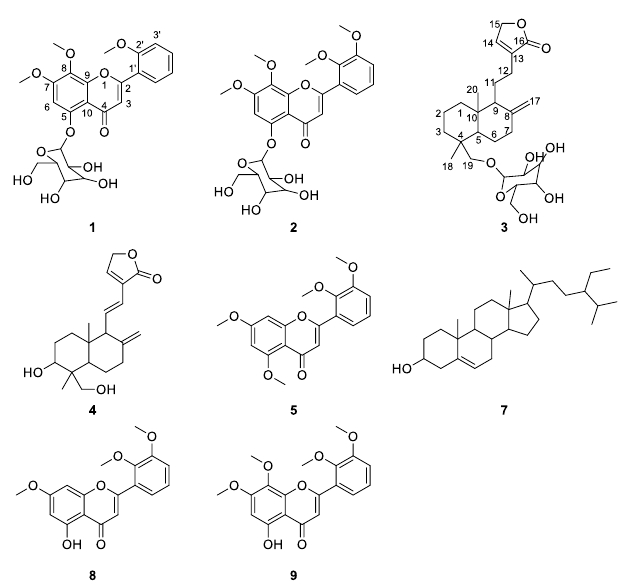
Figure 1. The structures of compounds identified in the cell extract of Andrographis Herba (AH). ( 1 . Andrographidine E, 2 . Andrographidine D, 3 . Neoandrographolide, 4 . Dehydroandrographolide, 5 . 5,7,2 (cid:48) ,3 (cid:48) -tetramethoxyflavone, 7 . β -sitosterol, 8 . 5-hydroxy-7,2 (cid:48) ,3 (cid:48) -trimethoxyflavone, 9 . 5-hydroxy-7,8,2 (cid:48) ,3 (cid:48) -tetramethoxyflavone).